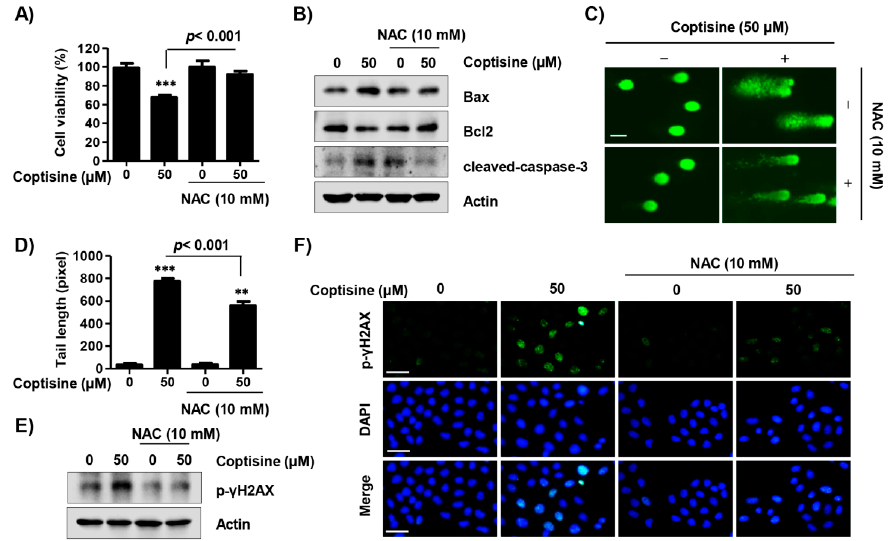
Figure 6. Induction of apoptotic cell death via ROS production by coptisine in Hep3B cells. Cells were pretreated with or without 10 mM NAC for 1 h followed by coptisine treatment for 24 h. ( A ) Cell viability was measured by an MTT assay. *** p < 0.001 vs. control; ( B ) The apoptosis regulatory proteins were detected by Western blot analysis; ( C ) Comet assay was performed, and representative images were taken by a fluorescence microscope. Scale bars. 50 µm; ( D ) The statistical analysis of tail length. ** p < 0.01 and *** p < 0.001 vs. control; ( E , F ) p- γ H2AX expression was assessed by Western blot analysis and fluorescence microscopy. DAPI staining was used to visualize nuclei. Scale bars, 30 µm. Int. J. Mol. Sci. 2020 , 21 , x FOR PEER REVIEW